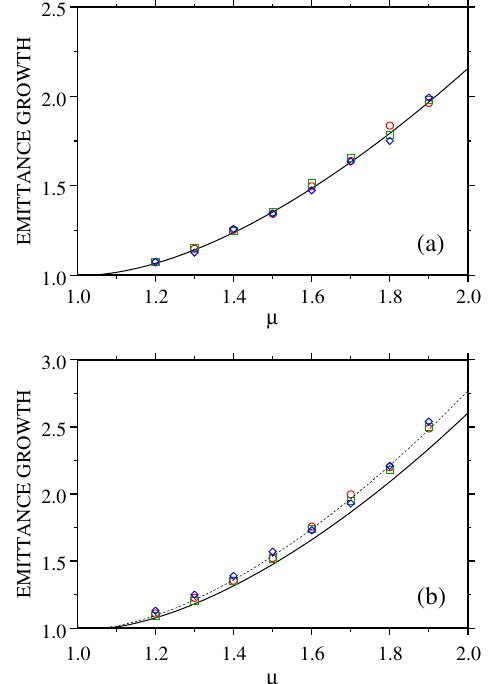
FIG. 3. Emittance growth (cid:5) s =(cid:5) as a function of the mismatch 0 parameter (cid:6) obtained from the theory (solid curve) and the (cid:5) N -particle simulations (symbols) for K=k ¼ 0 : 1 in (a) and 0 0 (cid:5) K=k ¼ 1 : 0 in (b). The symbols correspond to the different 0 0 initial distribution in the simulation: waterbag (circle), semi- Gaussian (square), and Gaussian beam (diamond). The dashed line in panel (b) corresponds to the emittance obtained using the exact form of the self-energy instead of the approximation given by Eq. (23). It shows that an improved estimate can be obtained by using the exact self-energy expression for larger mismatches and more space-charge dominated